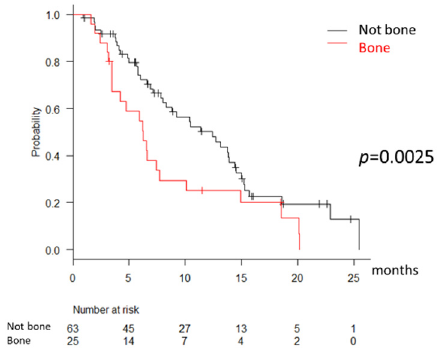
Figure 2. Progression-free survival according to the metastatic sites.